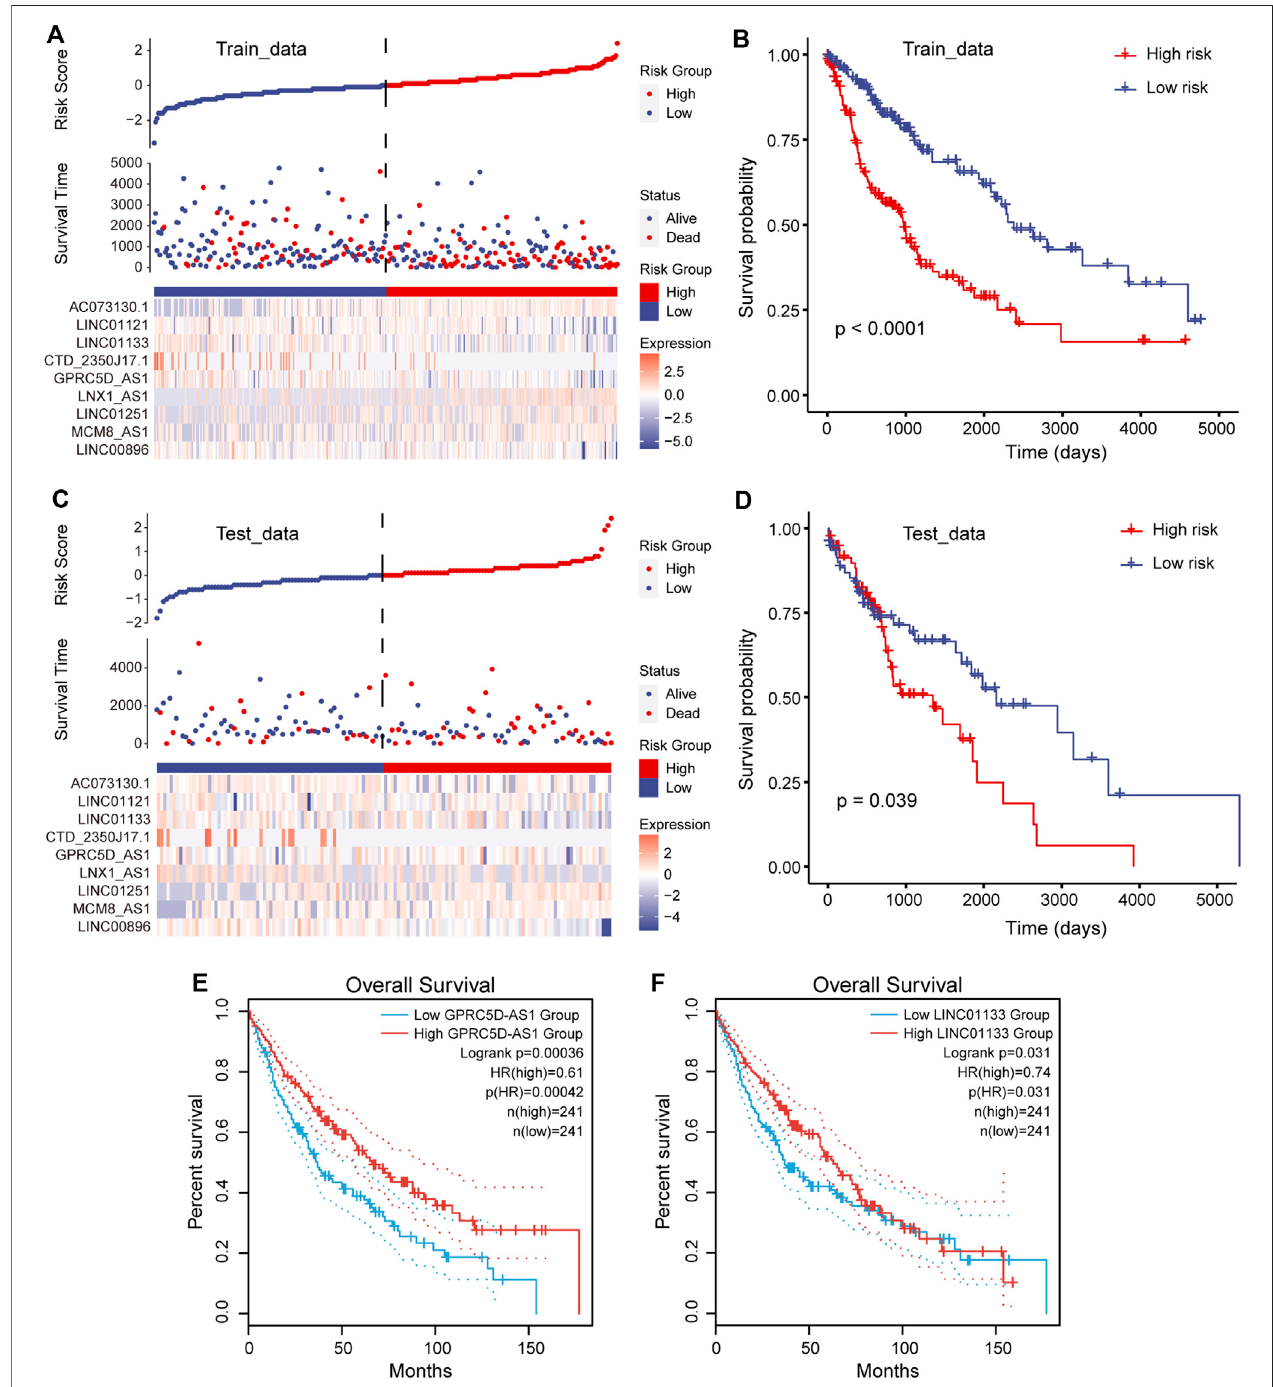
FIGURE3| Construction ofriskscoringmodel. (A) Riskscores,survivalstatus,andtheexpression ofnineprognosis-relatedlncRNAs(pr-lncRNAs)forthetraining set. (B) TheKaplan – Meiercurvesforthetwogroupsinthetrainingset.Log-ranktestisusedtocalculatestatisticalsigni fi cance.Theunitoftimeisdays. (C) Sameasin (A) but for the testing set. (D) Same as in (B) but for the two groups in the testing set. (E – F) The Kaplan – Meier curves for survival in groups with high and low expression (FPKM) of lncRNA GPRC5D-AS1 and LINC01133.